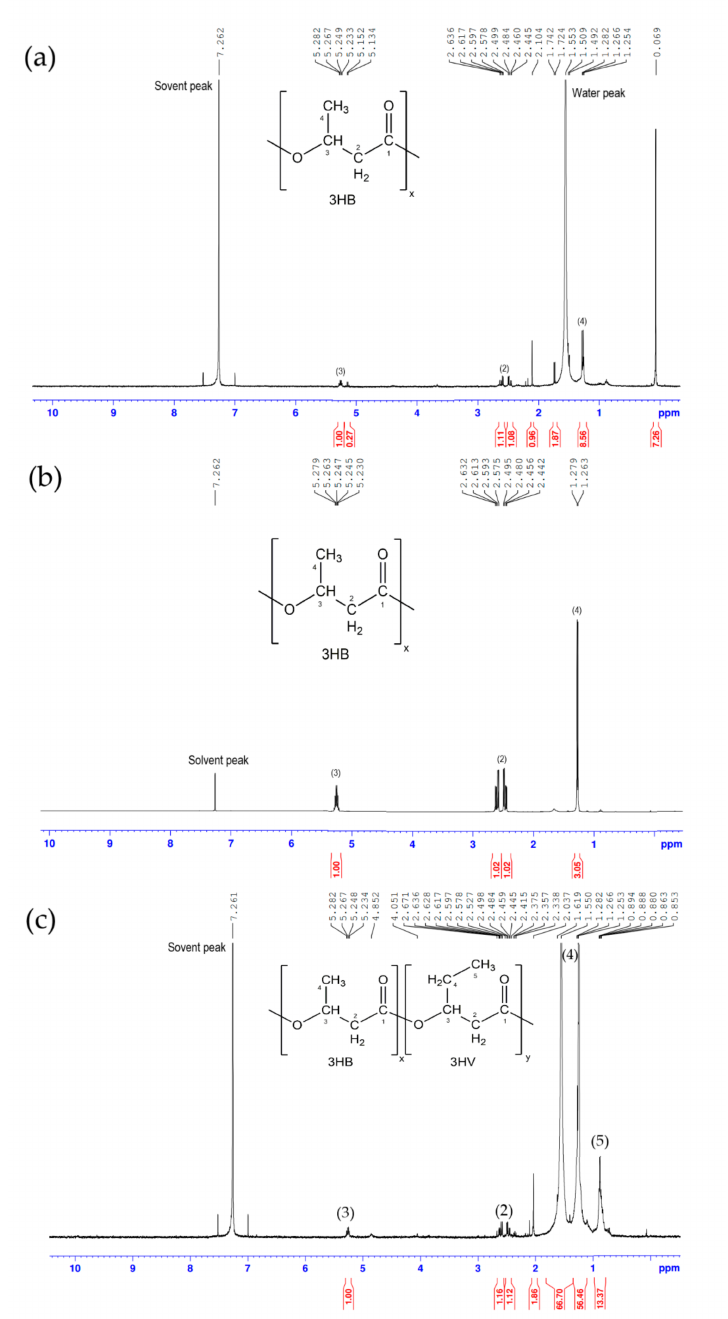
Figure 5. The 1 H NMR spectra of PHA produced by ( a ) Bacillus megaterium ALA2, ( b ) Cupriavidus necator KCTC 2649, and ( c ) Haloferax mediterranei DSM 1411 using 0.3 N HCl DCB hydrolysate as the carbon